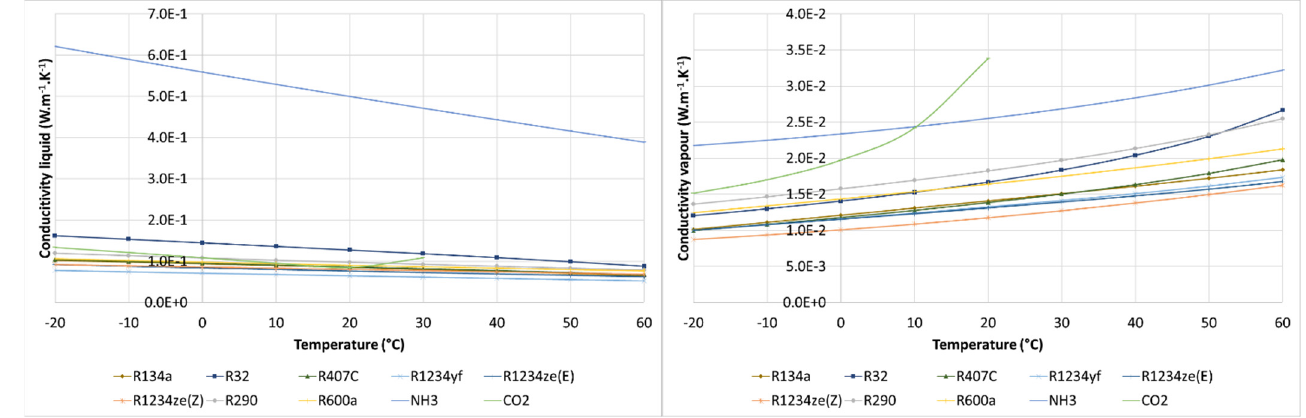
Figure 9. Comparison of evolutions of specific heat depending on temperature.